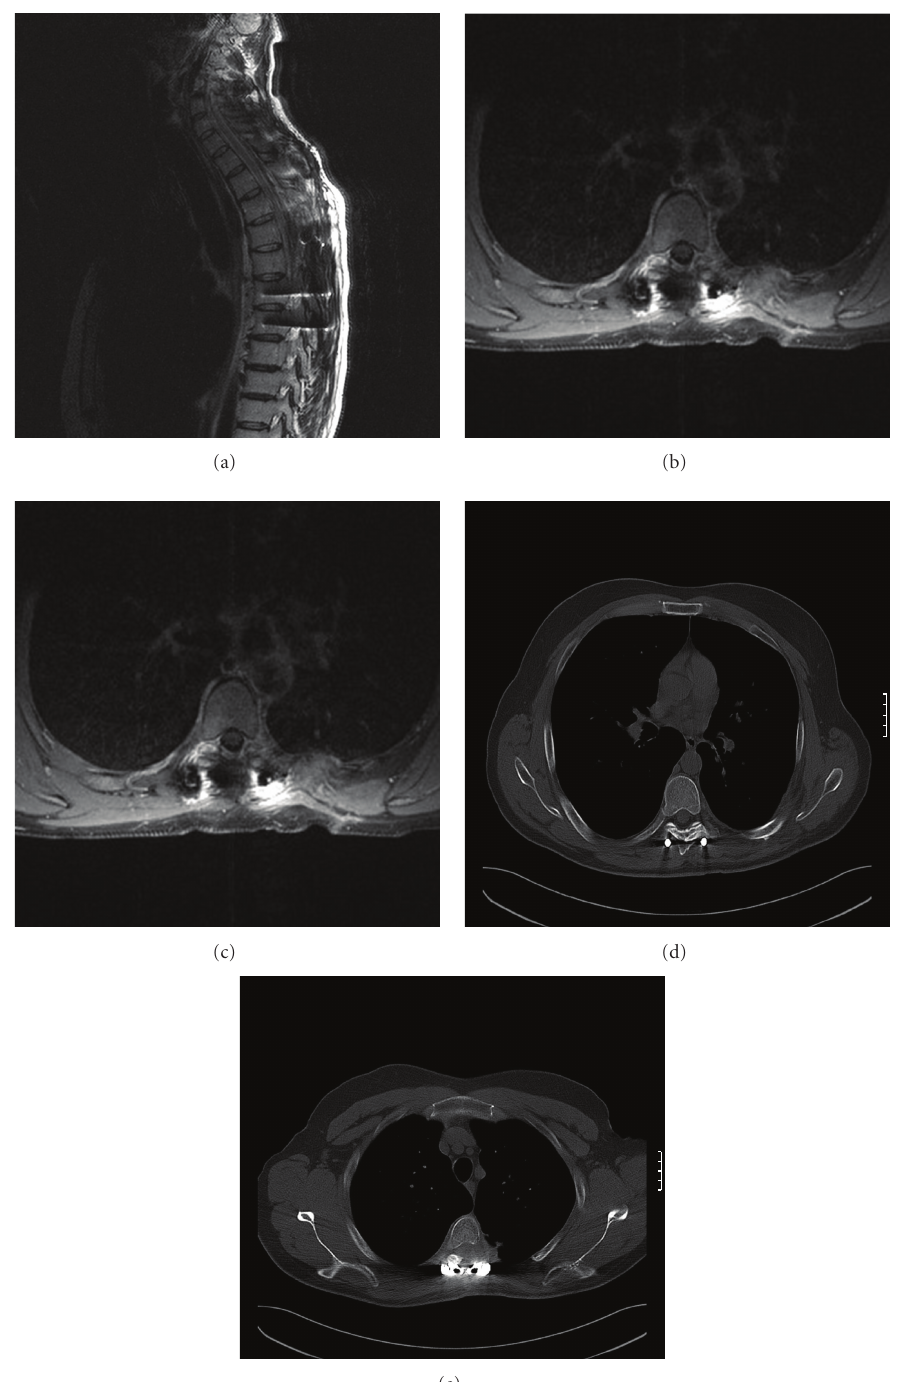
Figure 5: Postoperative MRI (a, b, c) and CT scan (d, e) show no evidence of recurrence six months after the